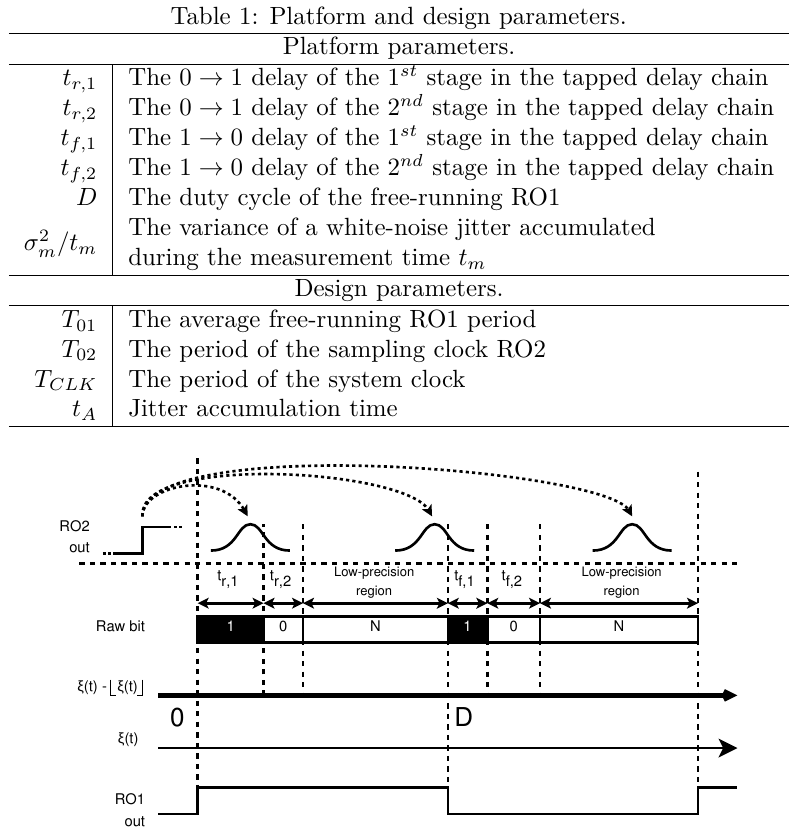
Figure 4: Variable-precision phase